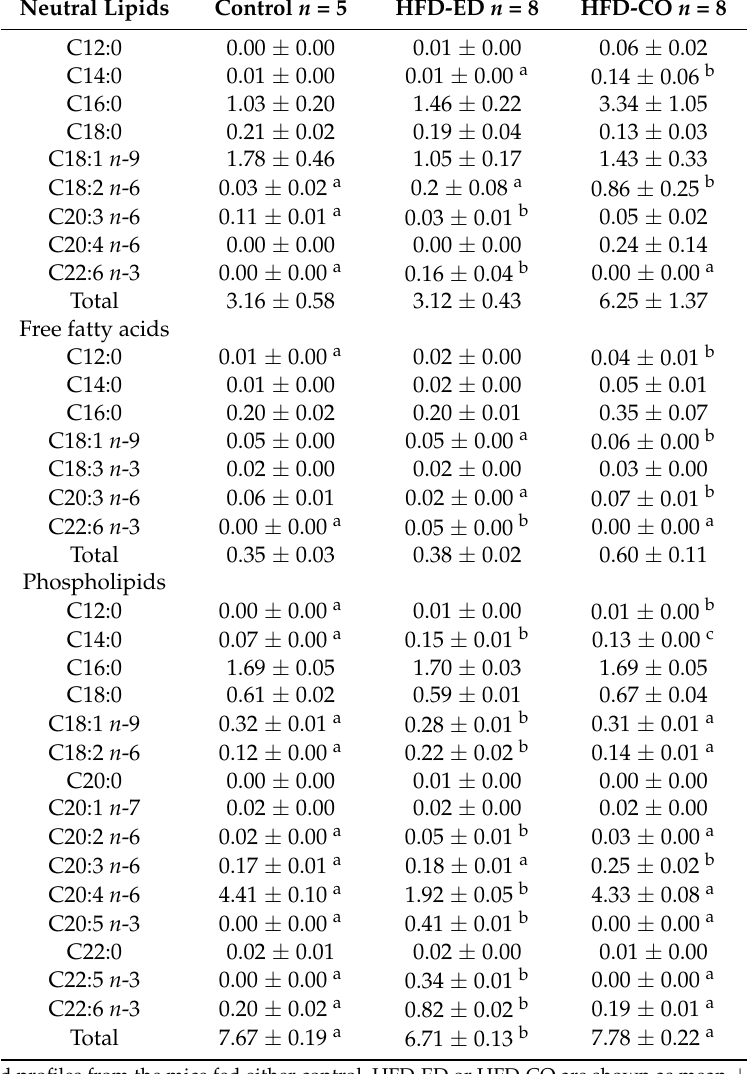
Table 3. The fatty acid profiles of different lipid fractions in spleen tissues (mg/g dry spleen